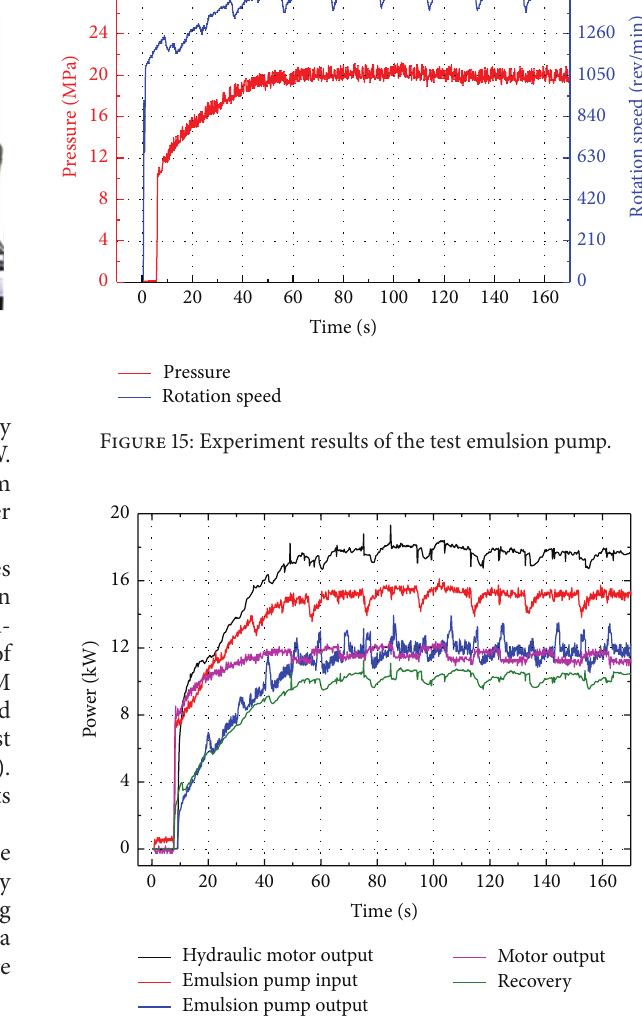
Figure 16: Power consumption of major components by experi-